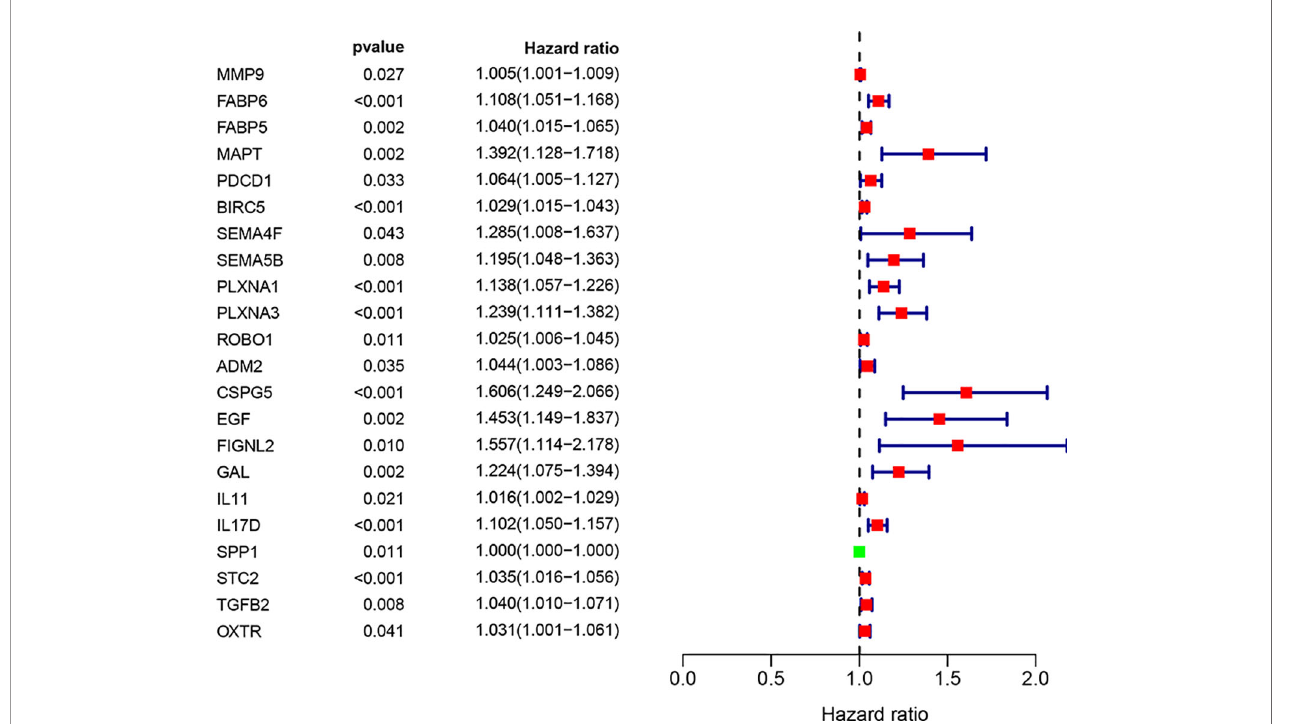
FIGURE 2 | Prognostic values of survival-associated IRGs: Forest plot of survival-associated